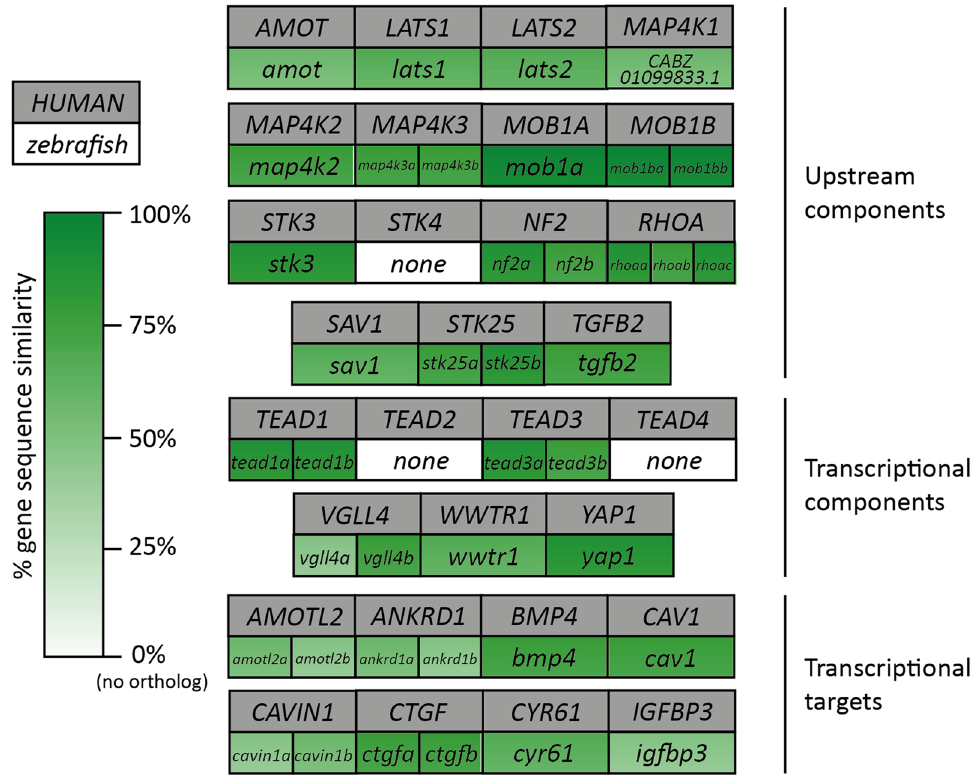
Fig. 2 Similarity between selected human and zebra fi sh Hippo pathway genes. Direct gene sequence comparison between a sample of human and zebra fi sh Hippo pathway members and transcriptional targets shows a range of similarity scores, emphasizing a high degree of similarities between fi sh and human genes, while also highlighting that some Hippo pathway components appear to have no direct orthologs present in both species. WWTR1 encodes TAZ. STK4 encodes MST1 and STK3 encodes MST2 (in accordance with the consensus of the Hippo pathway fi eld). CYR61 is also known as CCN1 and CTGF as CCN2 . % gene sequence similarity identi fi ed using ensembl.org under orthology tab. ctgfb , nf2b , map4k2 , and rhoaa-c could not be identi fi ed as orthologues in this manner, so manual BLAST comparison of genomic sequence (from GRCz11) was performed to give the values indicated.